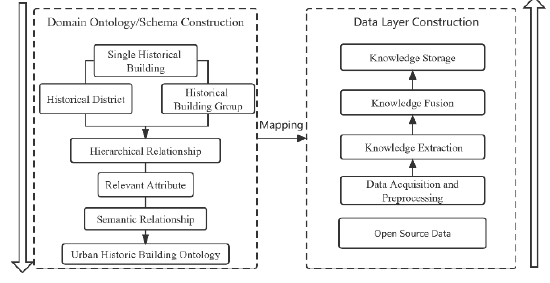
Figure 1. Workflow of the proposed framework for constructing KG for urban historical